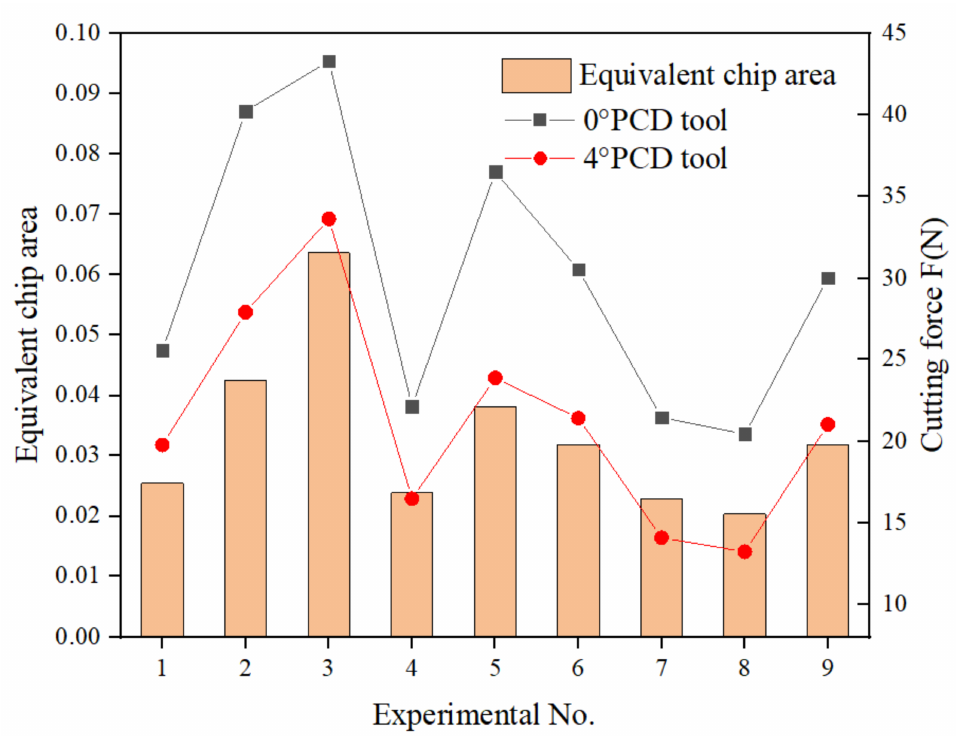
Figure 6. Variation of cutting force with equivalent cutting